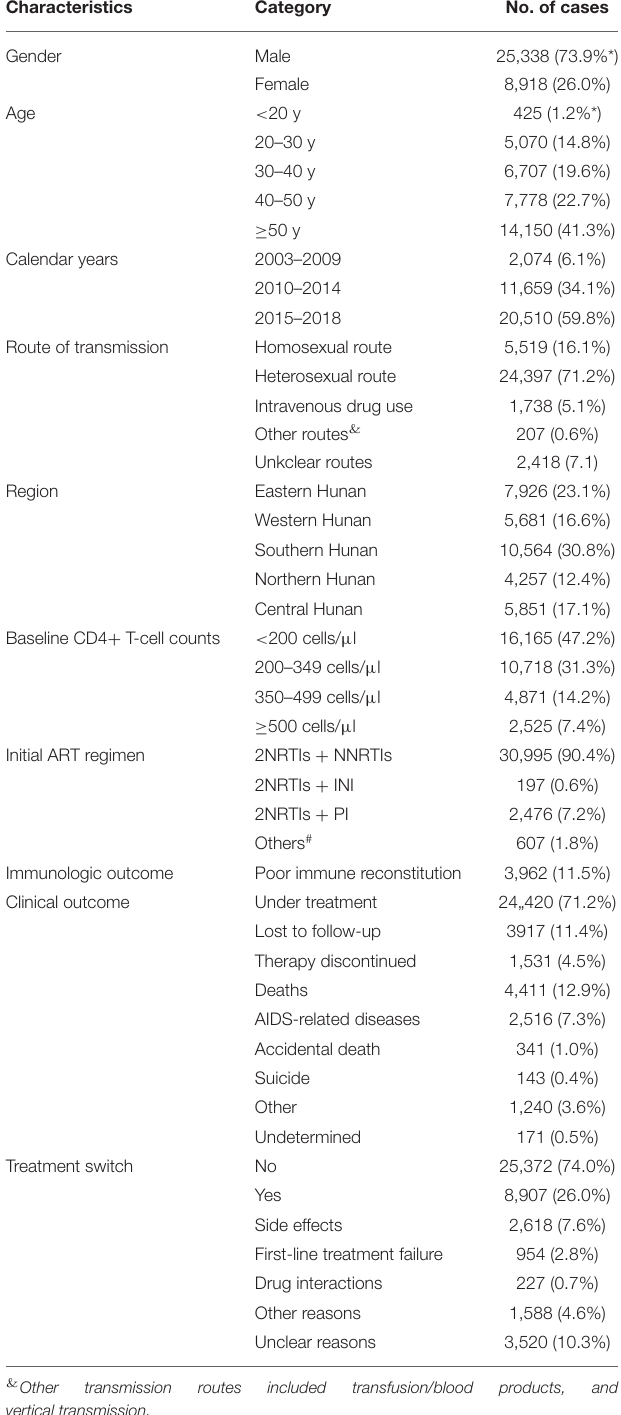
TABLE 1 | Demographic and clinical features of 34297 HIV-infected patients in Hunan